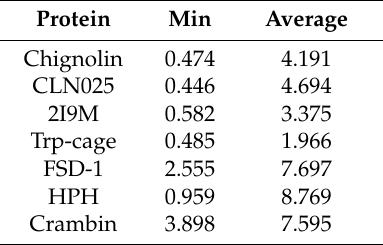
Figure 7. Root mean square deviations (RMSDs) of ( A ) chignolin; ( B ) CLN025; ( C ) 2I9M; ( D ) Trp-cage; ( E ) FSD-1; ( F ) HPH and ( G ) crambin in REMD simulations. The reference structures of RMSD calculations were experimental structures shown in Table 1. Table 4. The minimum and average RMSDs/Å values in REMD